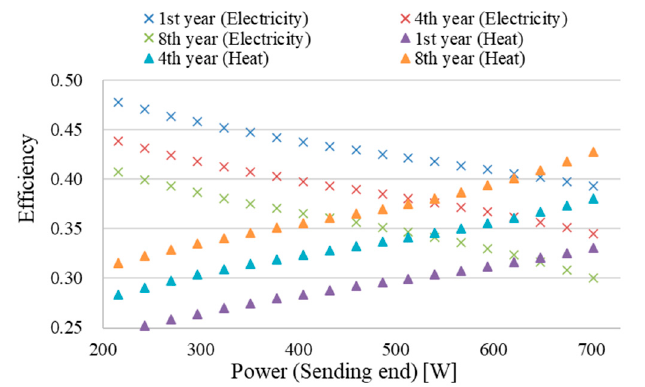
Figure 8. Effects of ECSA decrease rate on output power decrease rate [51].